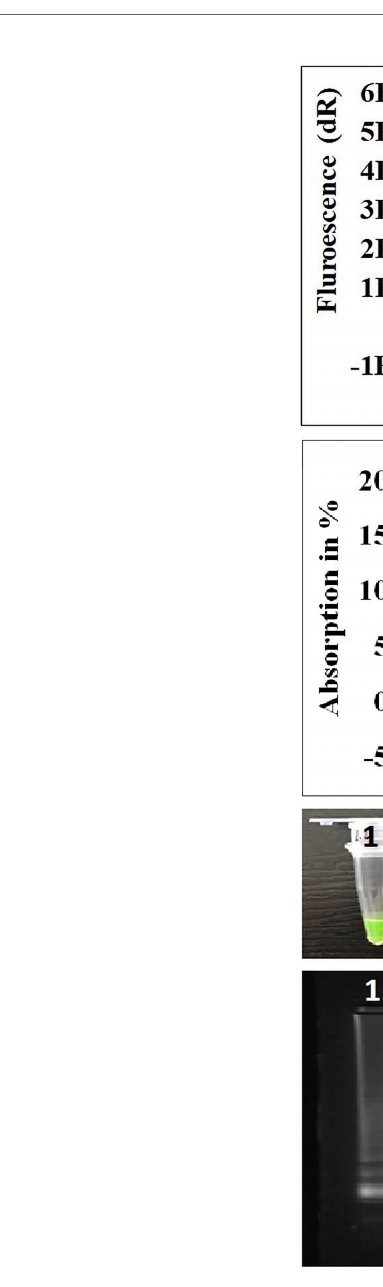
FIGURE 4 | The effect of Cod-UNG-rRT-LAMP assay in different detection principles. (A) Fluorescence detection method, (B) turbidity detection method, (C) direct visual detection method (in positive reaction color changed from orange to green, in negative reaction the color remains orange), and (D) gel electrophoresis method. In (A – D) , a serial 5-fold dilution of a positive clinical sample was prepared. 1:5 times dilution, 2:25 times dilution, 3:125 times dilution, 4:625 times dilution, 5:3,125 times dilution, 6:15,625 times dilution, 7:78,125 times dilution, NC, negative